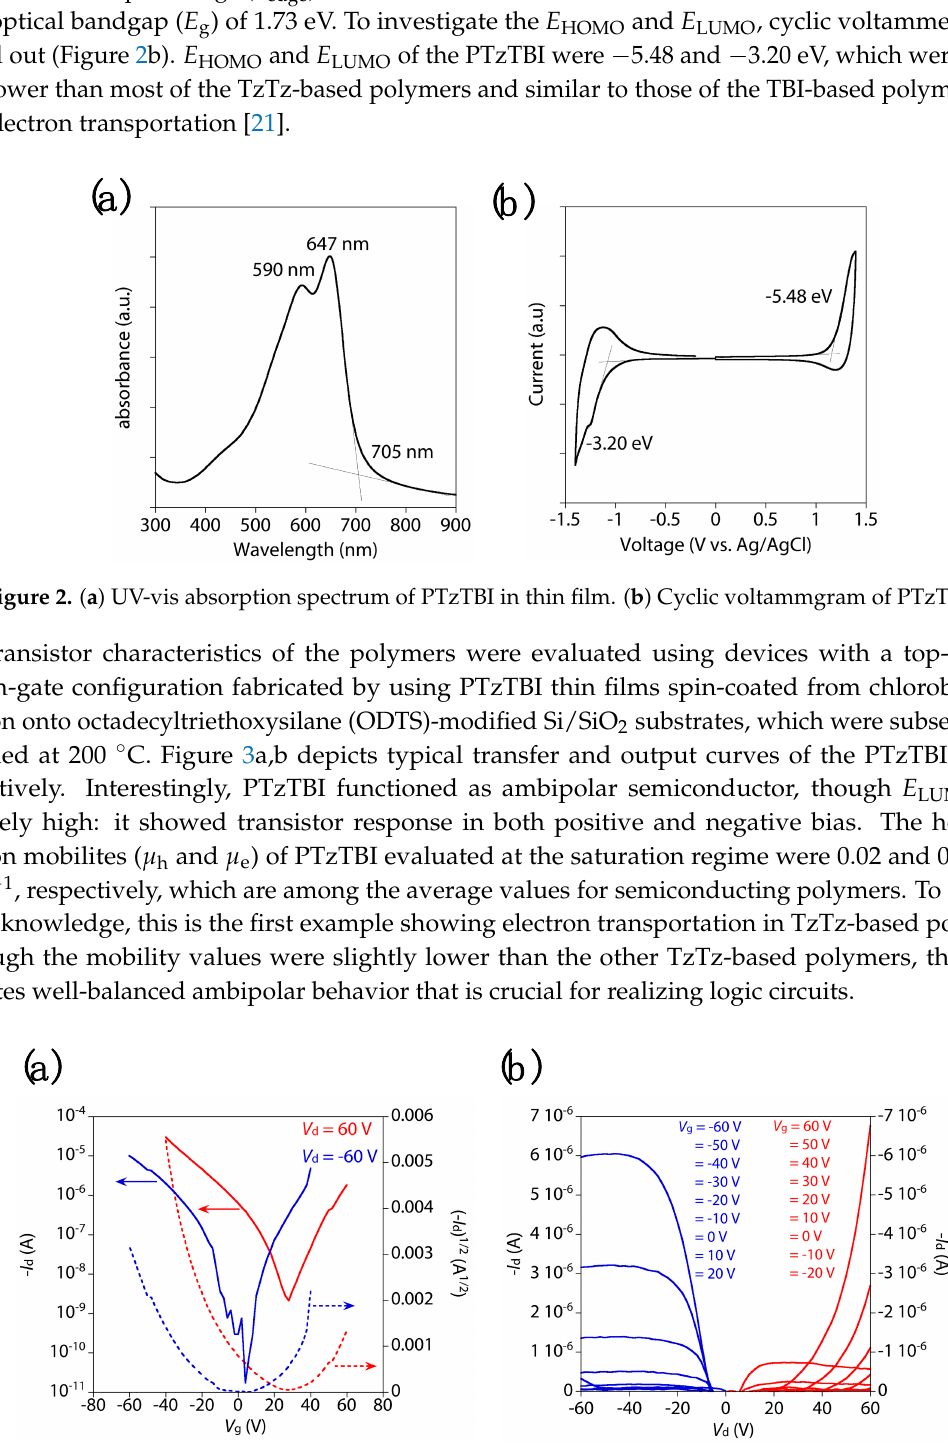
Figure 3. ( a ) Transfer curves ( p -channel: V d = − 60 V, n-channel: V d = 60 V) and ( b ) out-put curves ( p -channel: V g = − 60~20 V, n-channel: V g = 60~ − 20 V) of a PTzTBI-based field-effect transistor (OFET).